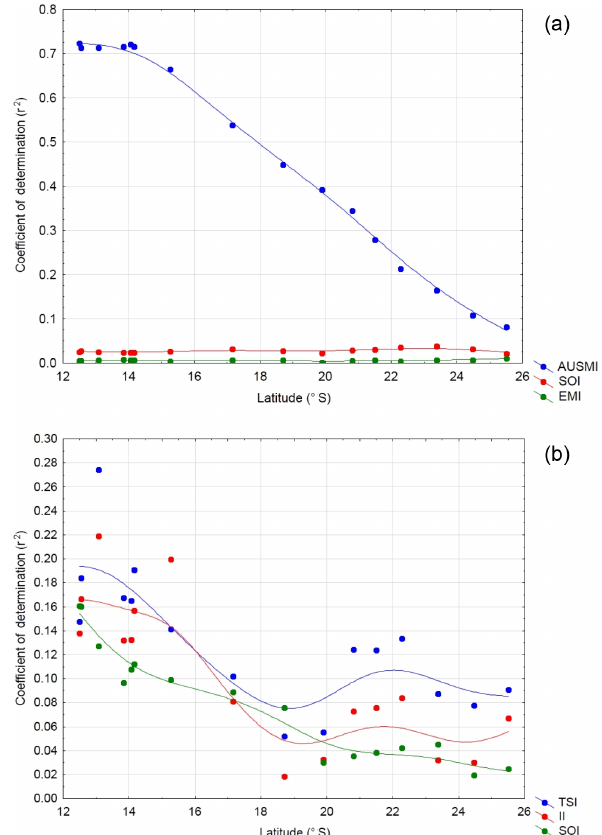
Figure 8. The three most highly correlated climate indices ( r 2 ) on average along the NATT (Table 1) for the period 1900 to 2010. Sites are plotted as their latitude along the transect. Correlations are shown for (a) monthly and (b) yearly averaged daily rainfall. For monthly correlations, AUSMI had the strongest correlation, fol- lowed by SOI, then EMI. For annual correlations, TSI showed the strongest correlation on average over the entire NATT, followed by II then SOI. A distance weighted least squares fit has been included to aid the illustration of the trends along the